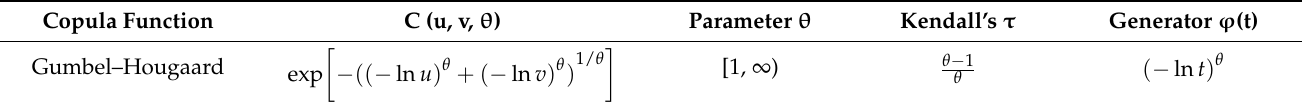
Table 2. Mathematical description of the applied Gumbel–Hougaard copula. Copula Function C (u, v, θ ) Parameter θ Kendall’s τ Generator ϕ (t)